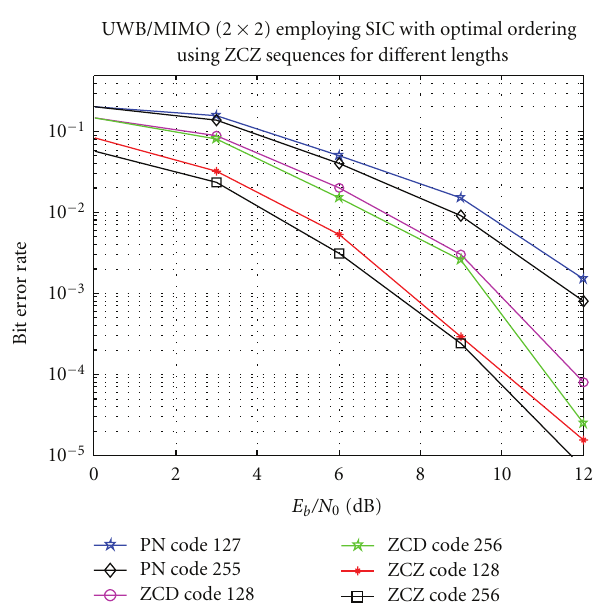
Figure 5: Performance of UWB/MIMO (2 × 2) system employing SIC with optimal ordering using ZCZ sequences for di ff erent seq- uence lengths.